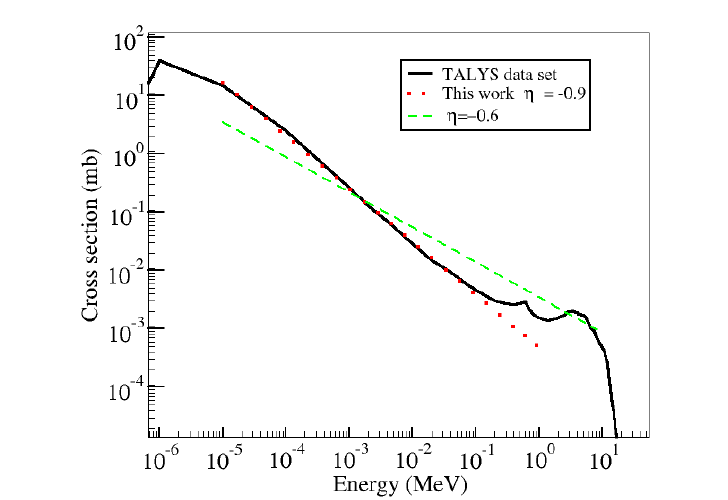
Figure 1. Neutron capture cross section off 39 Mg. The solid black line shows the full dataset obtained with TALYS 1.9 [10]. The dotted red line shows our fit to a power-law as in Equation (3). The dashed green line corresponds to a power index as discussed in Reference [6].